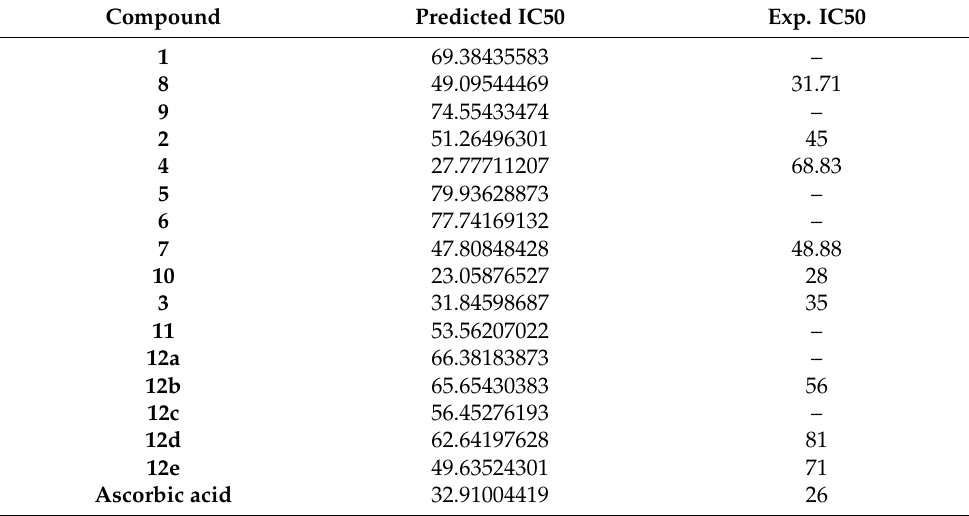
Table 7. The predicted antioxidant